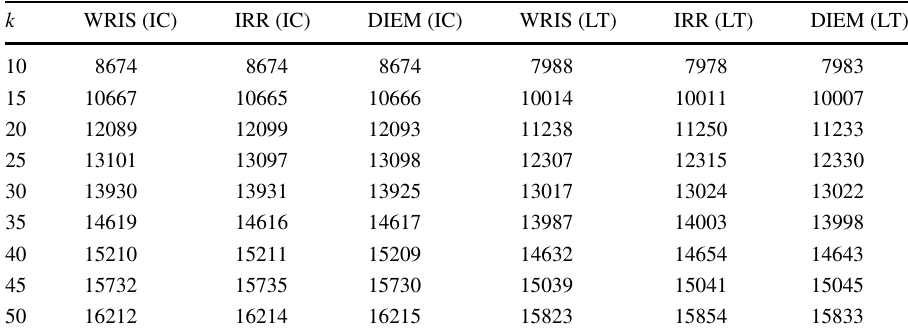
Table 5 Targeted influence spread when varying k under IC and LT